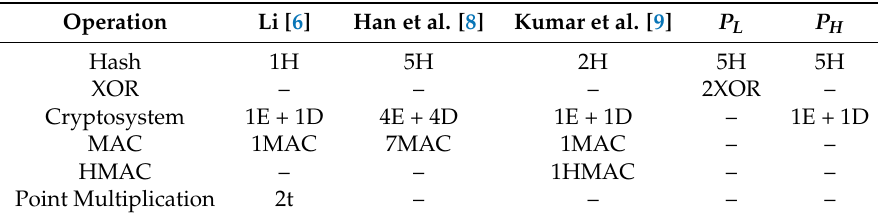
Table 6. Comparison of computational costs.